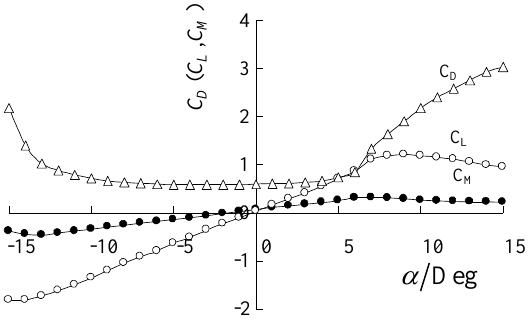
Figure 18. Correlation between aerostatic coefficients and the wind attack angles.